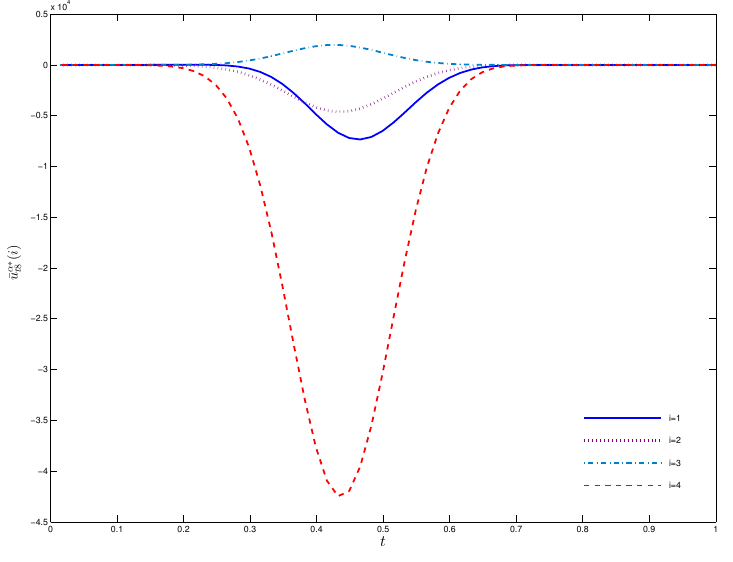
( i ) with respect to t for α = 0.5, i = 1, 2, 3, 4. Figure 2. ¯ u α ∗ t 8